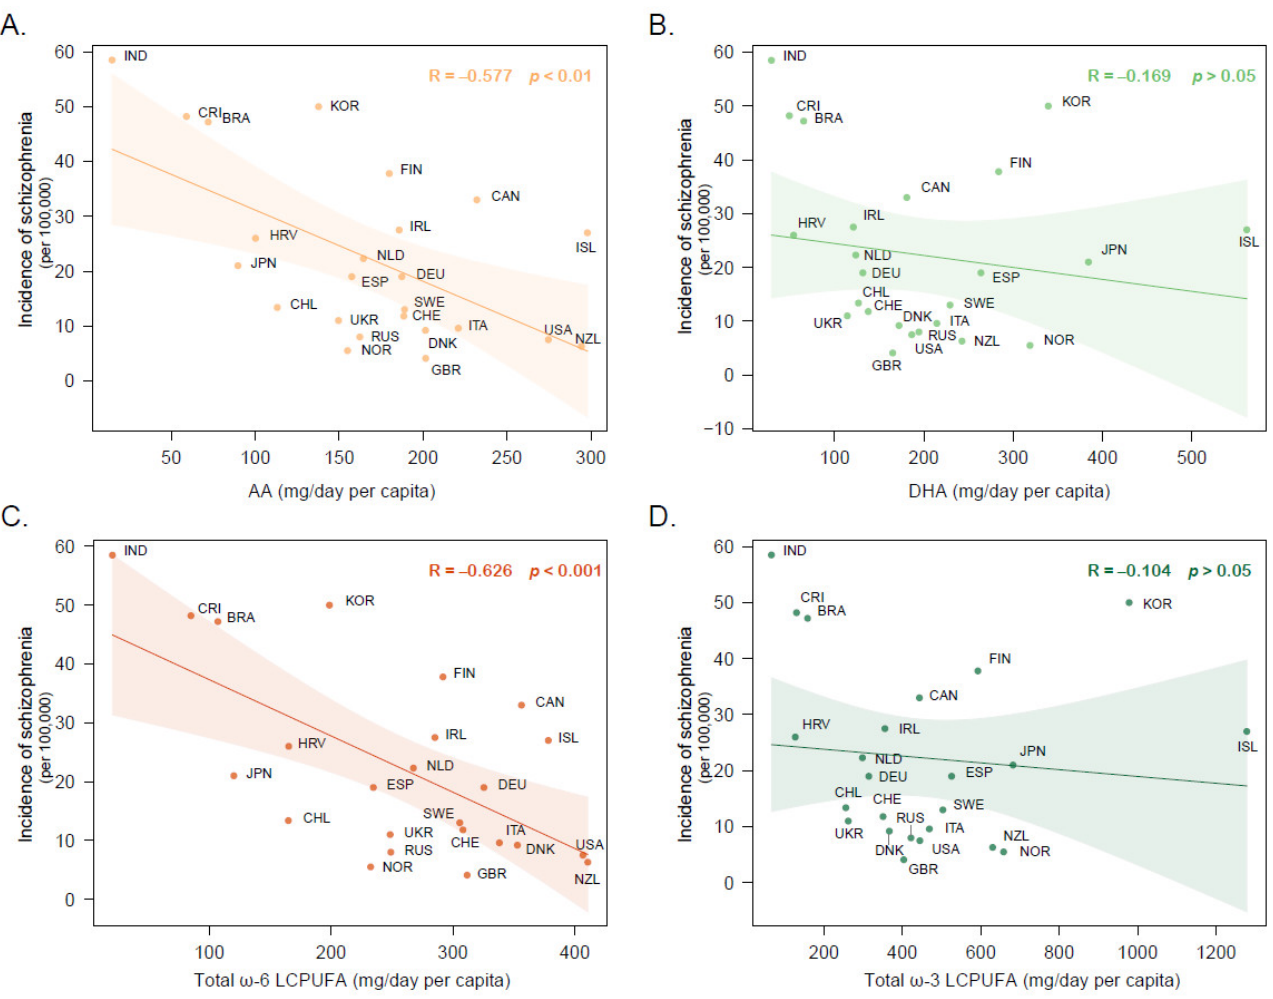
Figure 3. Correlations between schizophrenia incidence rates and ( A ) AA, ( B ) DHA, ( C ) total ω-6 LCPUFA, and ( D ) total ω-3 LCPUFA. Correlations described the relationship differences for AA (r AA = −0.577, p < 0.01), DHA (r DHA = −0.169, p > 0.05), total ω-6 LCPUFA (r ω-6 LCPUFA = −0.626, p < 0.001), and total ω-3 LCPUFA (r ω-3 LCPUFA = −0.104, p >